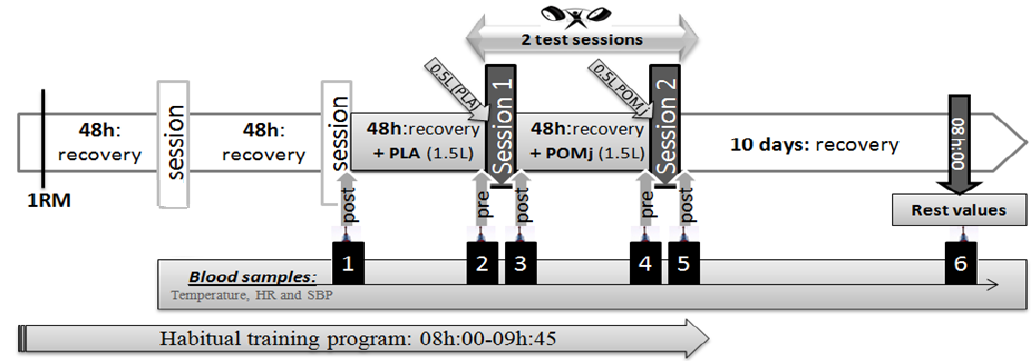
Figure 1. Experimental design.1-RM, One-repetition maximum; PLA, placebo; POMj, pomegranate juice.